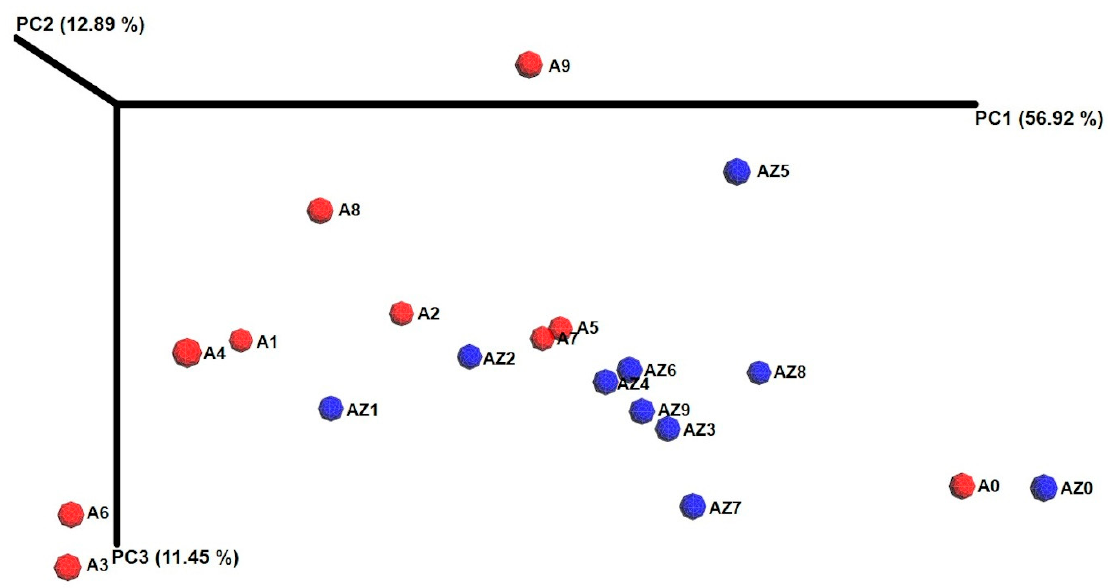
Figure 2. Principal coordinate analysis plot of maize silage samples, exhibiting dissimilarity of the microbial communities through the 90-days fermentation process. PC1 axis explains 56.92%, PC2 axis 12.89% and PC3 11.45% of total variance, respectively. Red dots stand for Antilope silage samples and blue dots for Amarillo Zamorano silage samples.